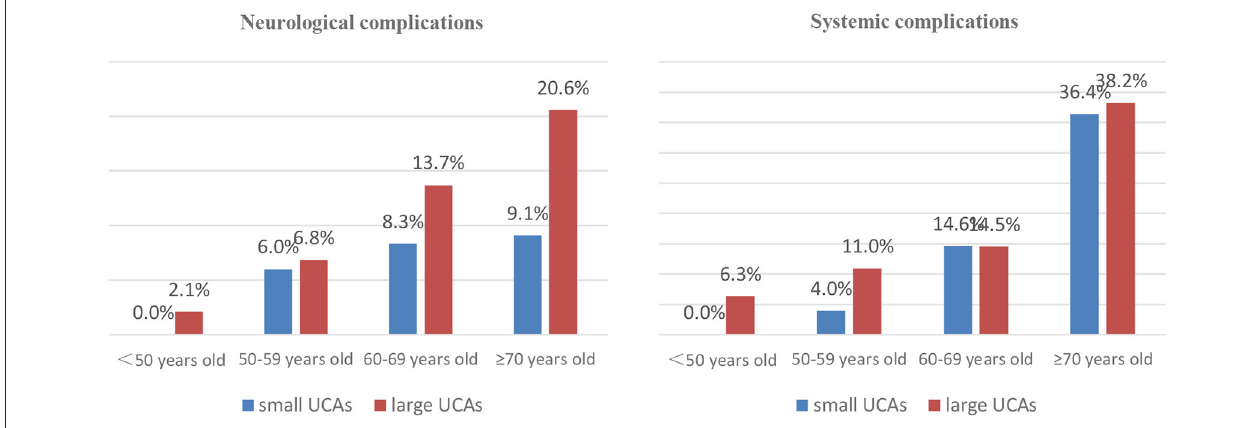
FIGURE 1 | The distribution of neurological and systemic complications according to age of patients.